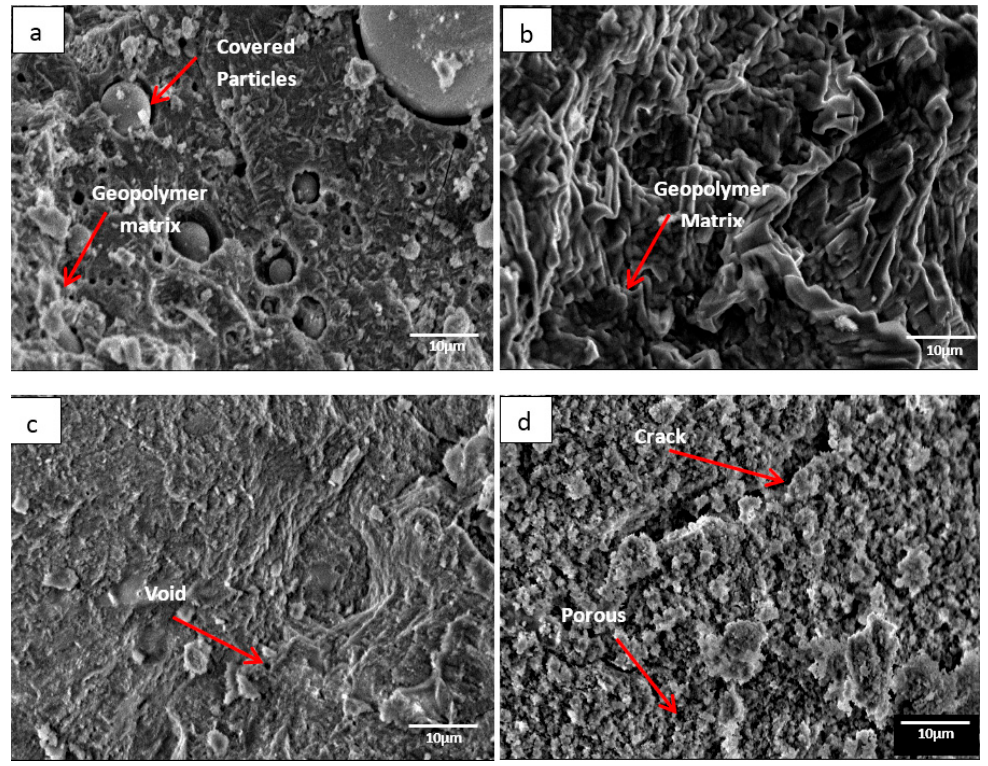
Figure 1. Microstructure of dolomite / fly ash geopolymer composite ( a ) before temperature exposure, after fire exposure at ( b ) 200, ( c ) 400, and ( d ) 1000 ° C.